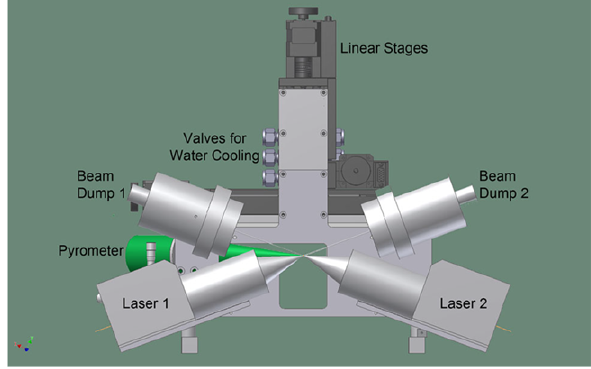
Figure 1: Setup for laser-based heating in the synchrotron radiation beamlines [32]